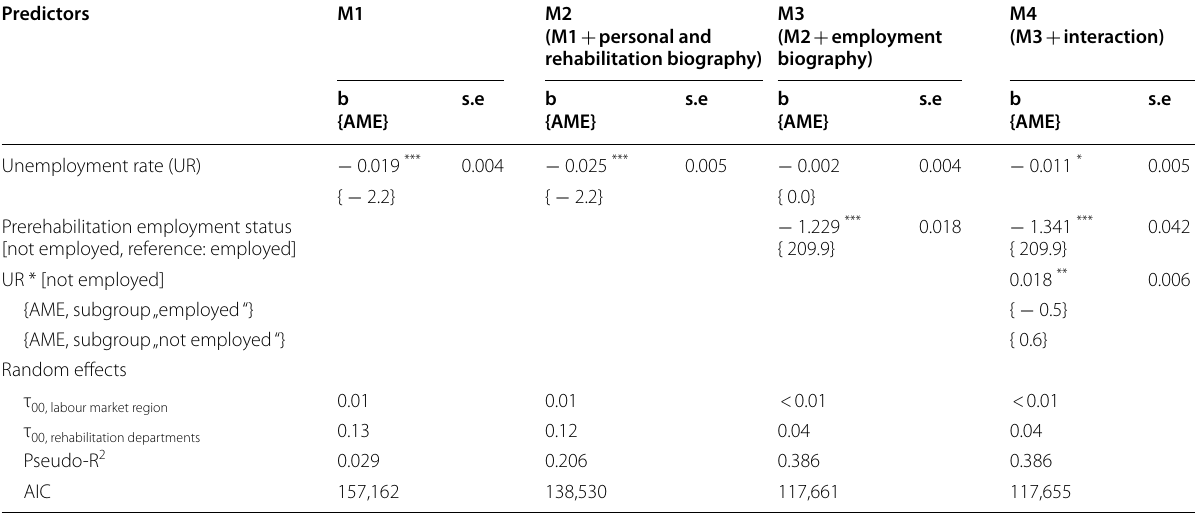
Table 4 Fractional logit regression models for RTW in psychosomatics